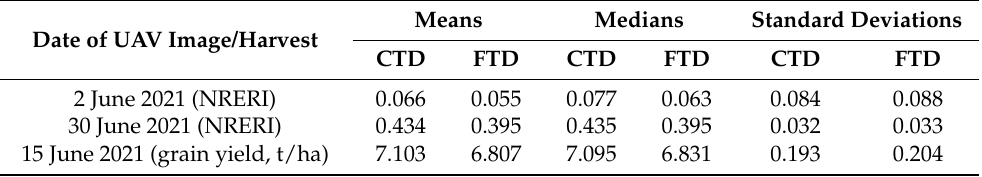
Table 2. Means, medians and standard deviations of NRERI from UAV images (without outliers from 2 June 2021) and grain yield from the yield map at controlled (CTD) and free (FTD) sites with Dystric Cambisol in the Za Frajmankou field.